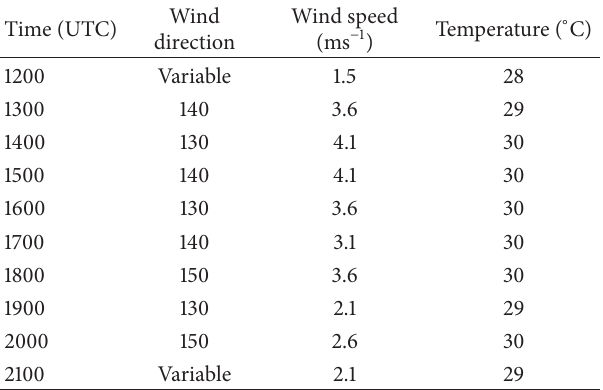
Table 1: The Barbados meteorological service (BMS) hourly METAR observations for 26 August 2008. BMS is located at 13.04N,